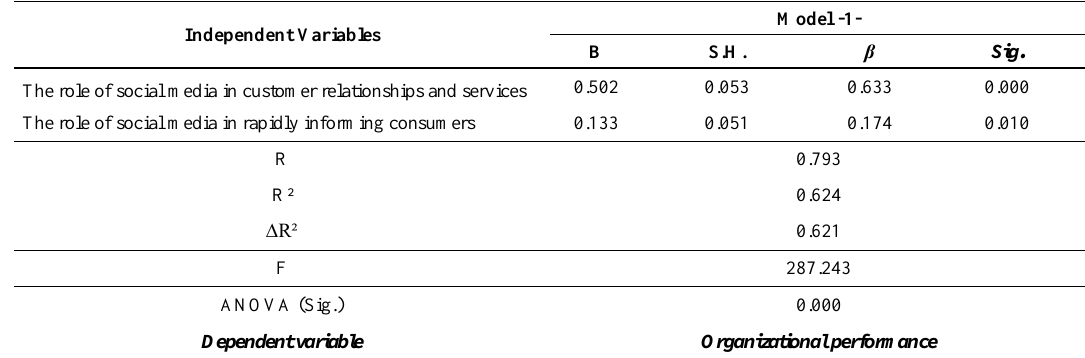
Table 8. Analyzes of